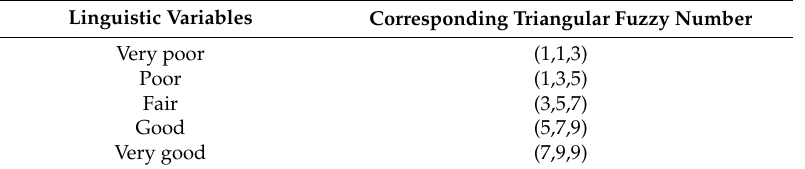
Table A2. Linguistic variables